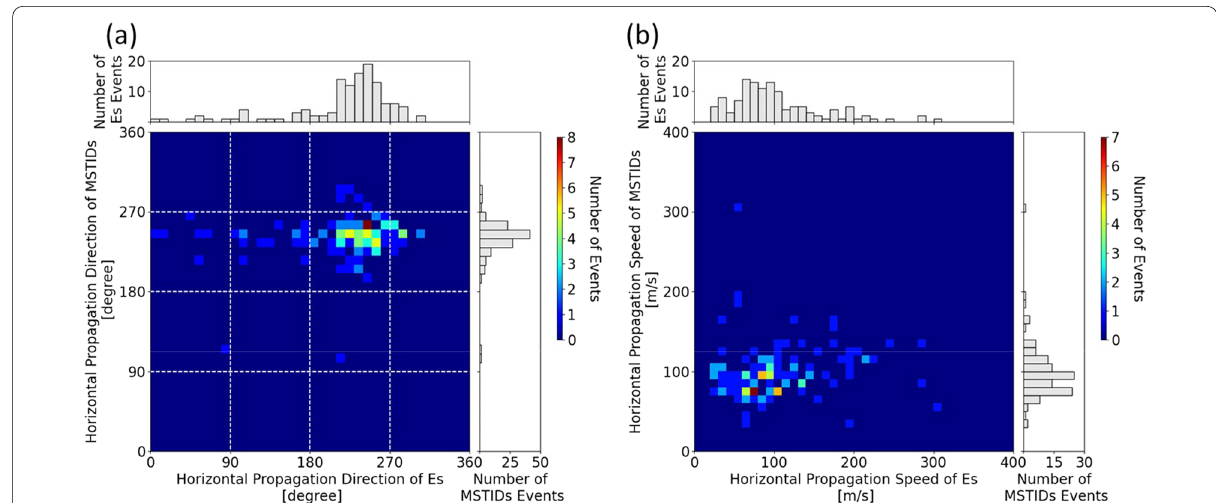
Fig. 5 Distributions of the directions and speed of Es and MSTIDs in 2014–2017. The total number of events is 122. a Propagation directions of Es and MSTIDs in 2014–2017. A number of samples are displayed in the central color map. In the top panel, the histogram shows the number of Es samples as a function of propagation parameter. In the right panel, the histogram gives the number of MSTIDs samples. b Speeds of Es and MSTIDs in 2014–2017 in a similar format as panel